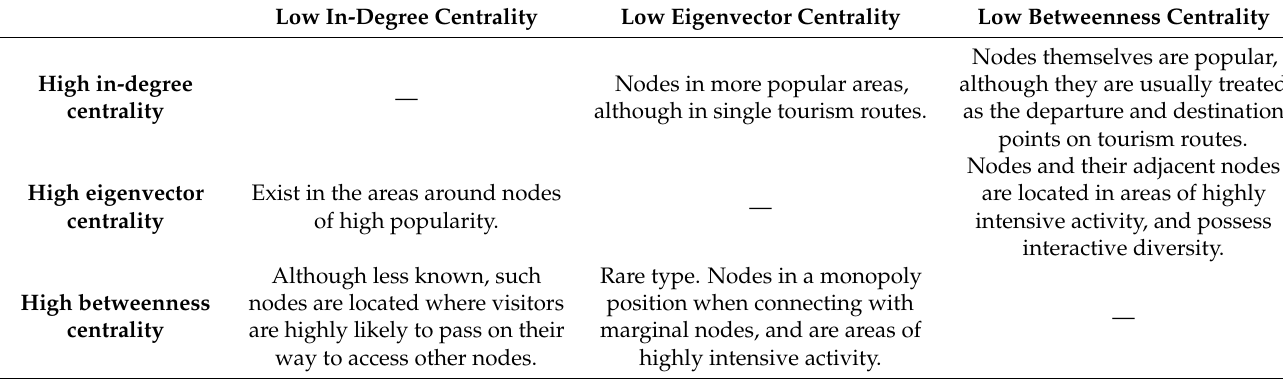
Table 1. Combination relationship of three types of node centrality in the tourism network. Low In-Degree Centrality Low Eigenvector Centrality Low Betweenness